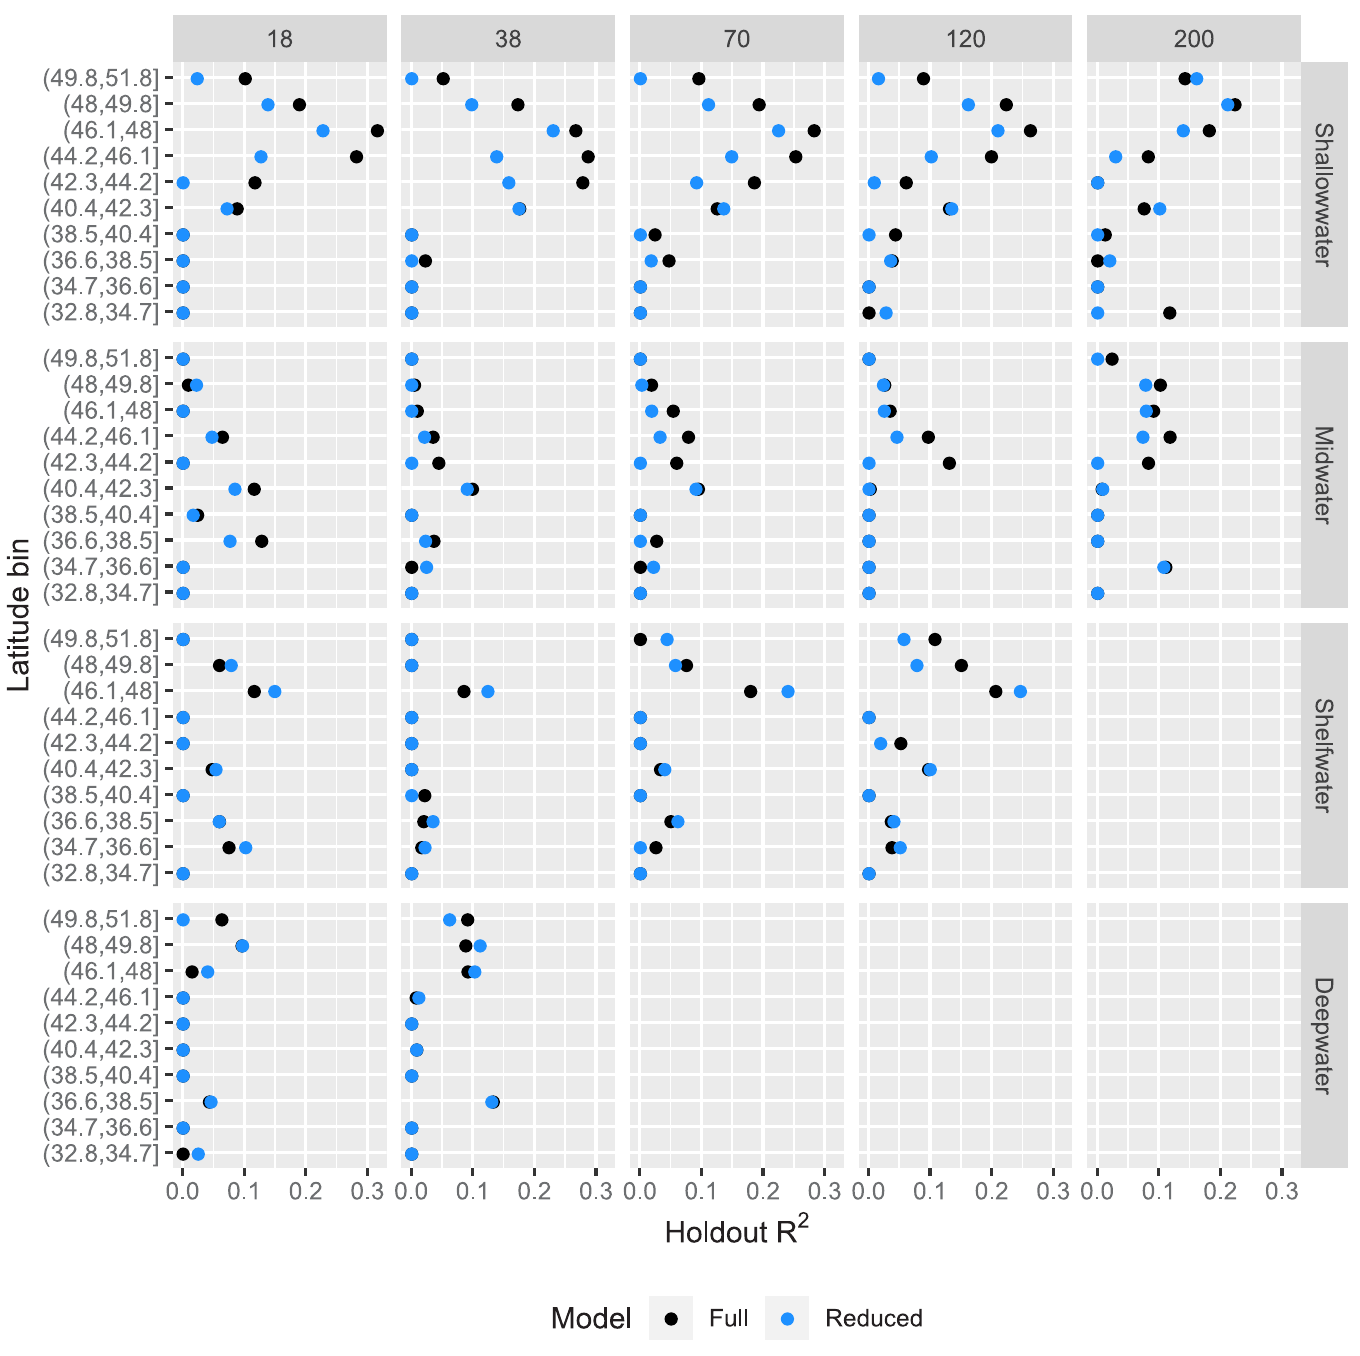
Fig 2. Spatial cross-validation. Spatial cross-validation performance comparison for the full model (black) inclusive of satellite observations, and the reduced model (blue) that excludes satellite observations, faceted by depth bin and sonar frequency (kHz). The x-axis displays the R 2 value on the withheld latitude bin, and the y-axis displays the latitude bin that was withheld during cross-validation. No results are shown for depth bin/frequency combinations for which the sonar data are known to be unreliable.